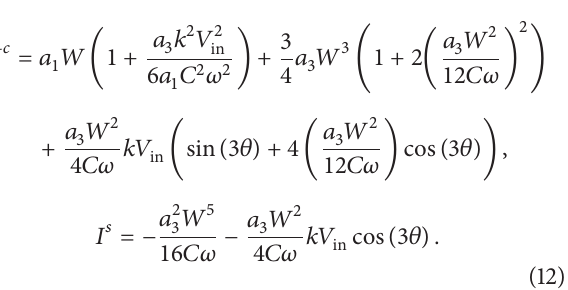
= 4.5𝑊/𝐿 = , 𝑉 PMOS NMOS DD